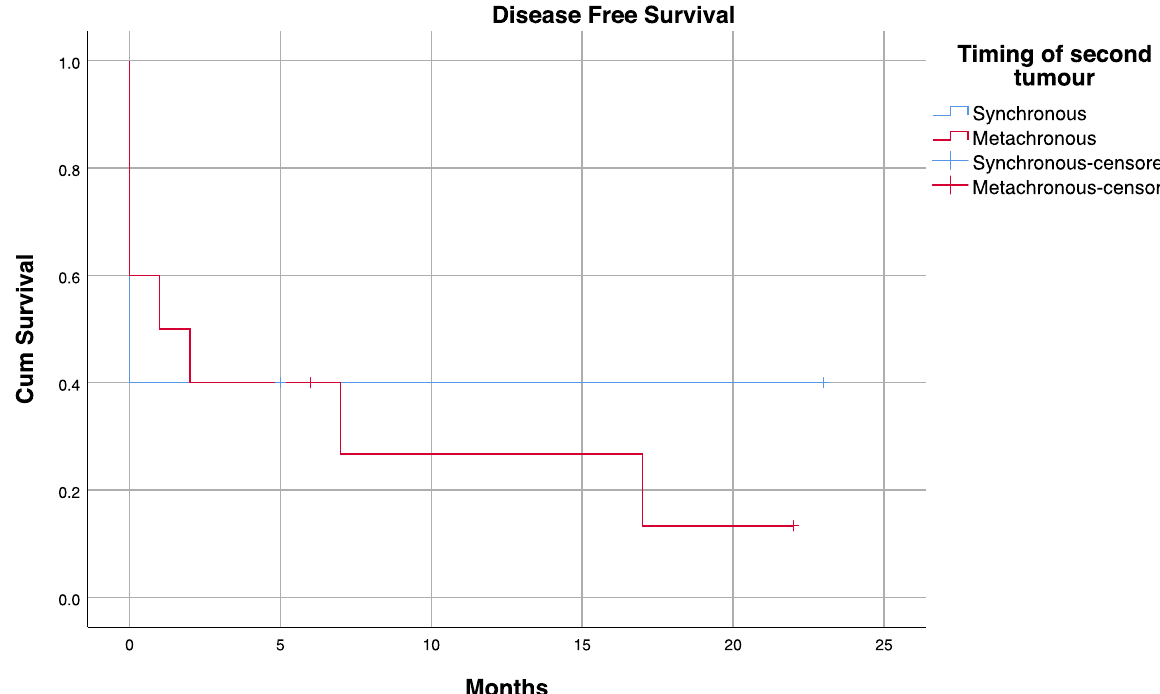
Fig. 3 Kaplan-Meier curve showing disease-free survival in synchronous vs. metachronous